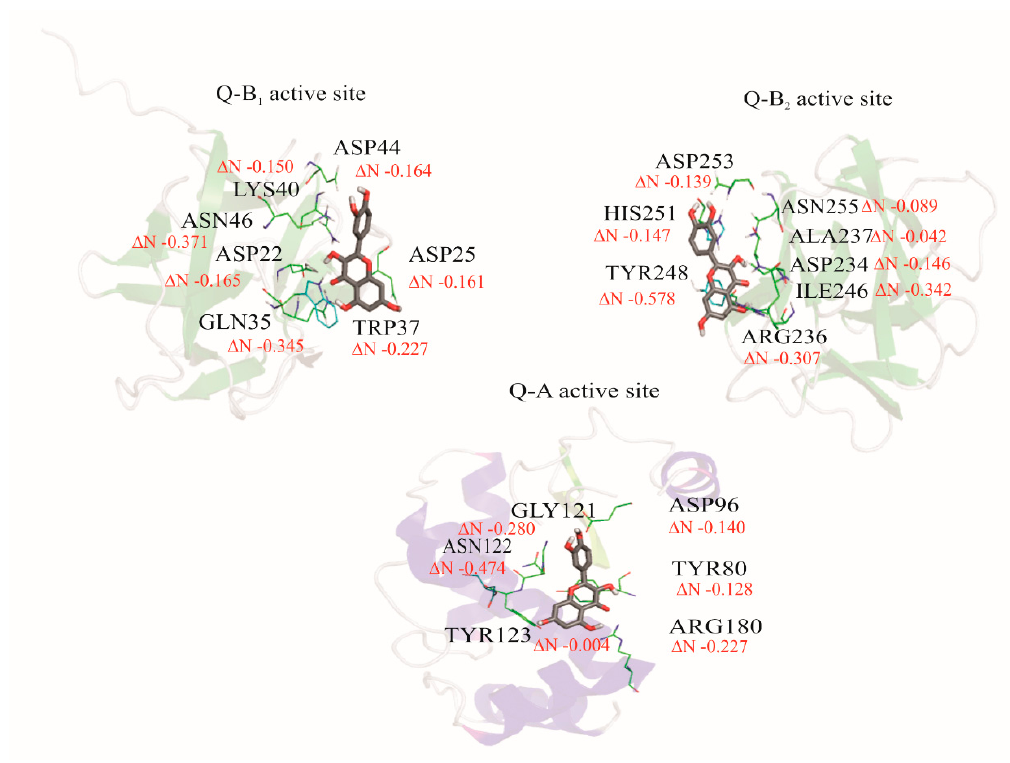
Figure 9. The schematization of the fractional number of transferred electrons ( Δ N) between quercetin and A, B 1 , and B 2 active sites of the ricin protein.